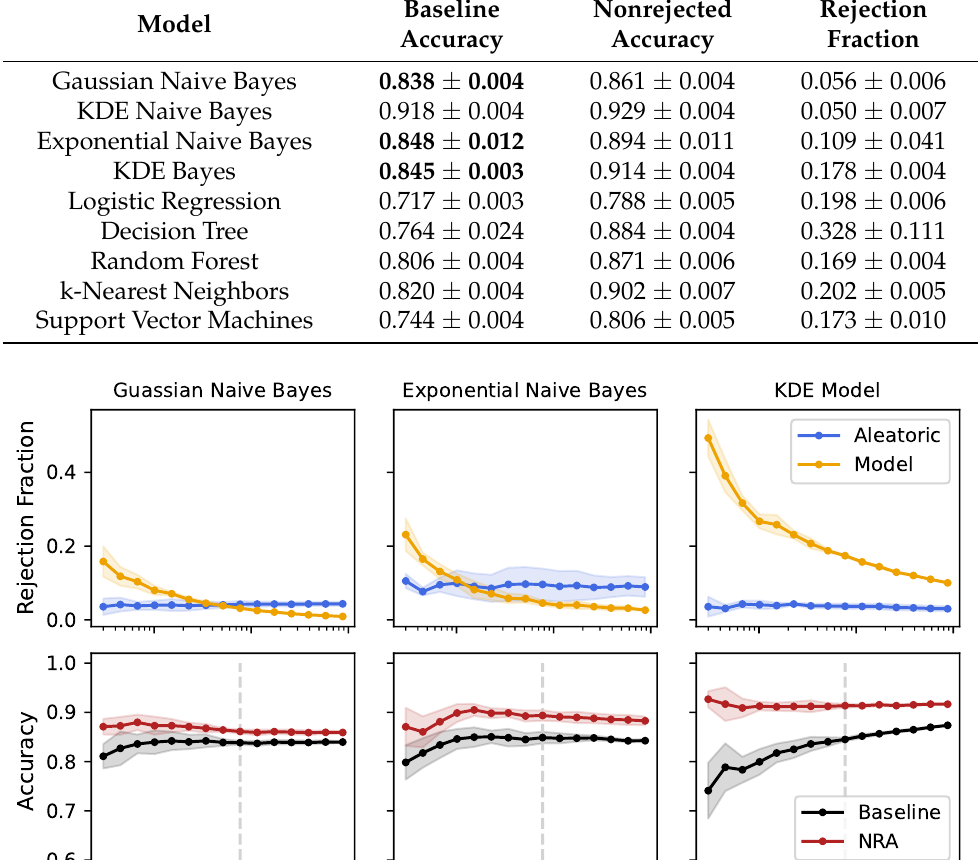
Table 1. Performance measures (mean ± standard deviation) for different models using a training size of 7692 samples. The highlighted baseline accuracies represent the selected models that were considered for further analysis, since the models attained similar accuracy values.